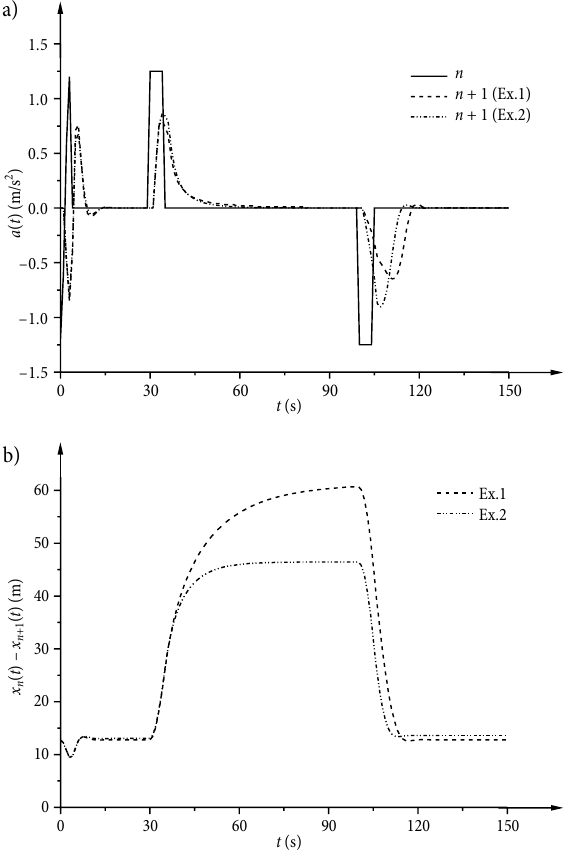
Fig. 1. Solution profiles in Examples 1 and 2: a – acceleration profiles; b – profiles of the distance headways between the lead and following